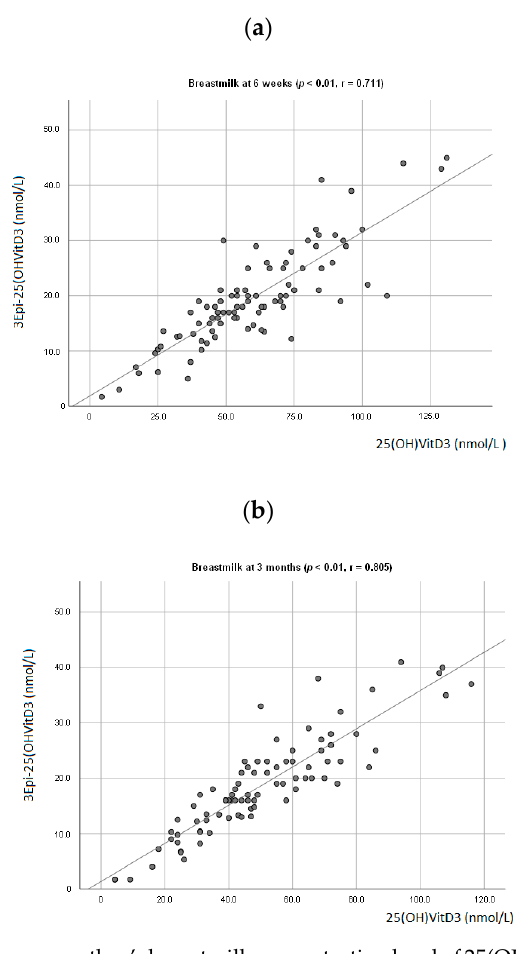
Figure 1. Association between mother’s breastmilk concentration level of 25(OH)D3 and 3-Epi25(OH)D3 at 6 weeks postpartum ( a ) and 3 months postpartum ( b ).